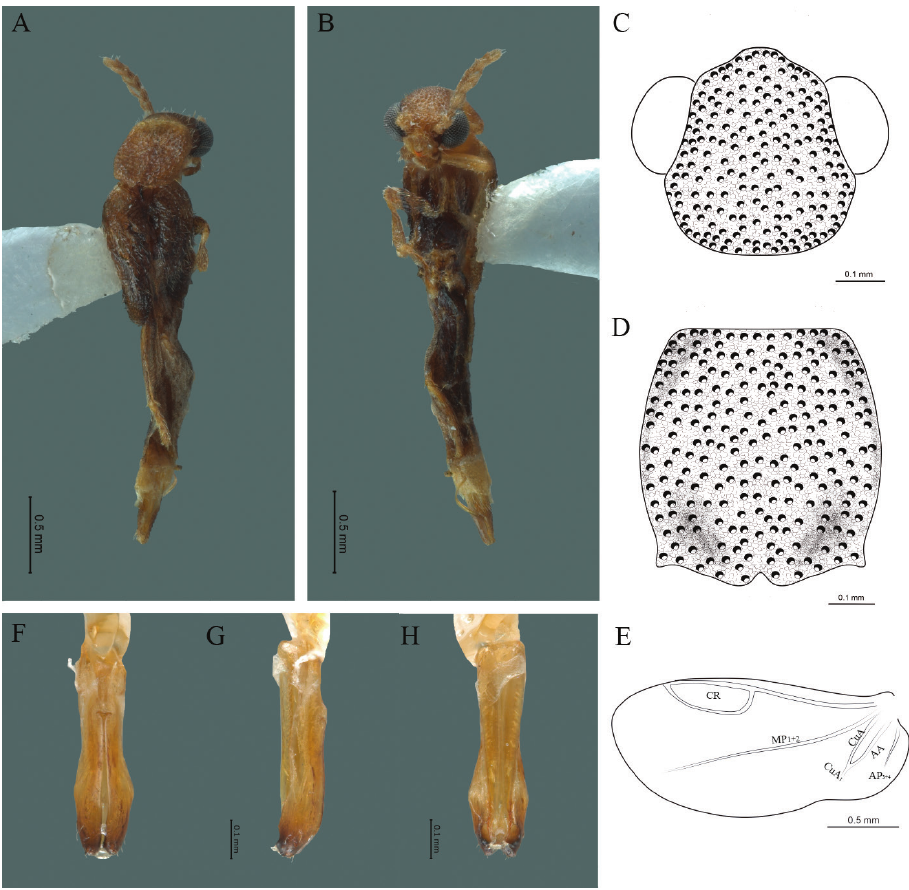
Figure 12. Cenophengus hautulcoensis Zaragoza-Caballero, 2008, male. Habitus: A dorsal B ventral C head dorsal D pronotum dorsal E hind wing. Wing venation: CR = Radial Cell; MP1+2 = Posterior Median vein; CuA = Cubital vein; AA and AP = Anterior and Posterior Anal veins. Aedeagus: F dorsal view G lateral view H ventral